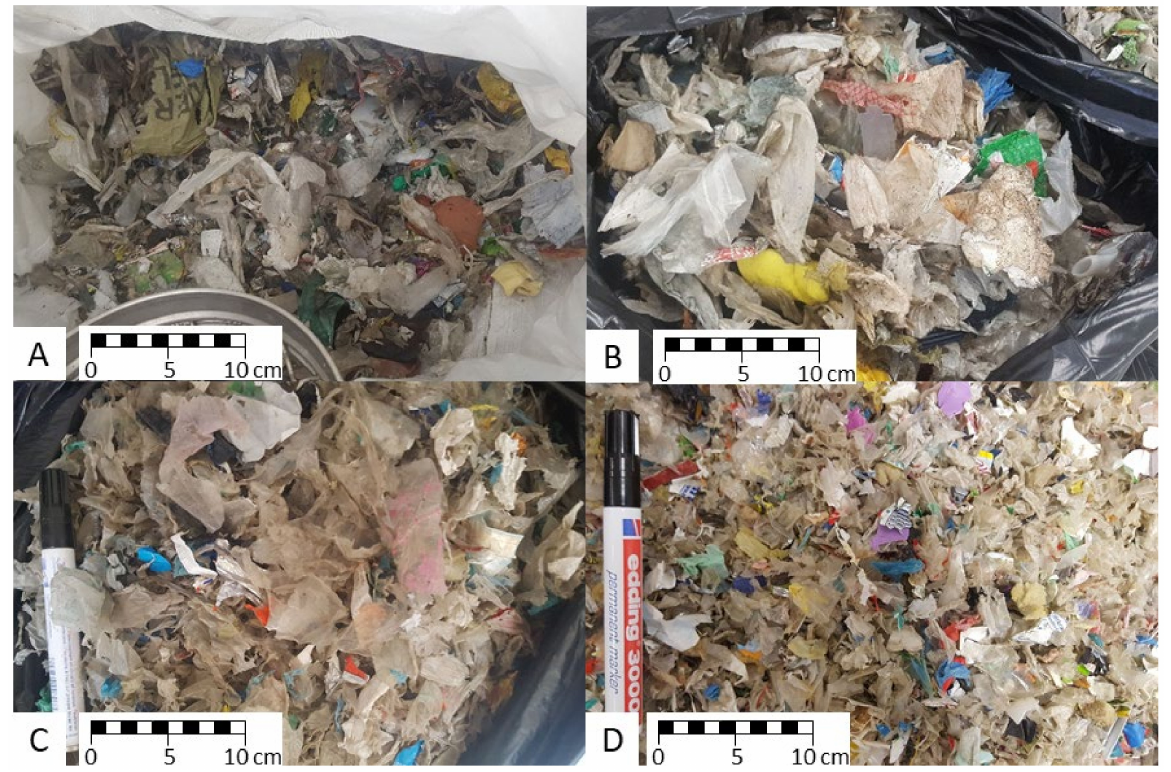
Figure A2. Exemplary photos of the input materials: SRF in ( A ) and ( B ), PO_A in ( C ), and PO_B in ( D